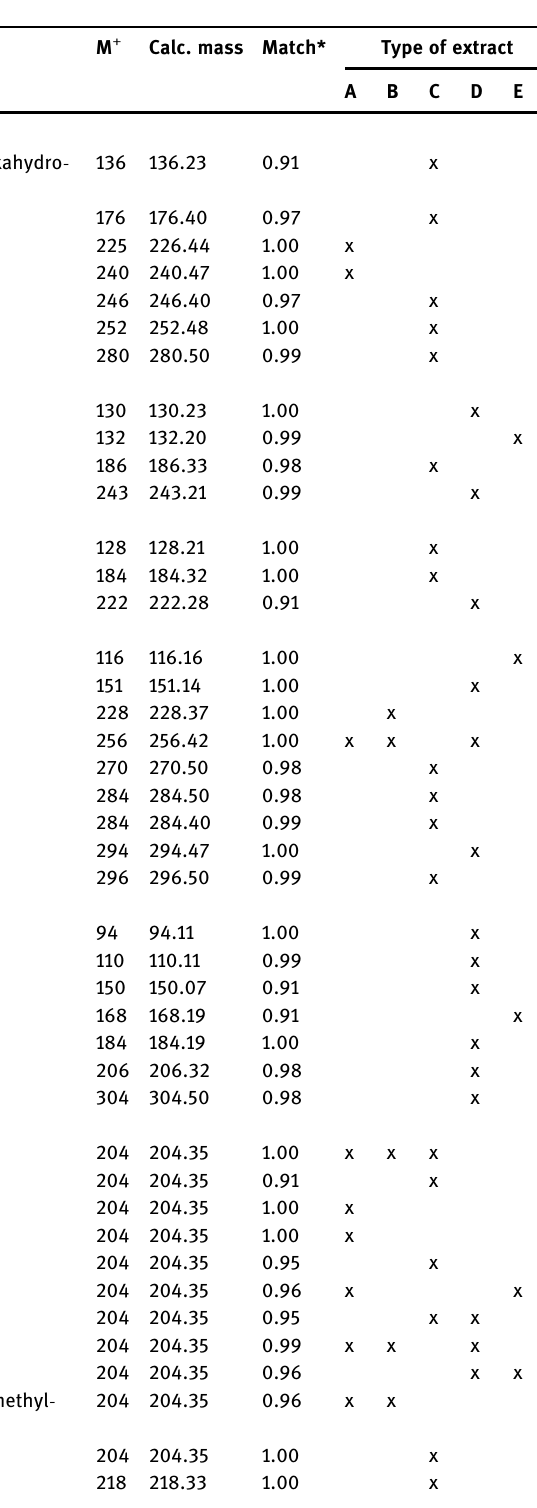
Table 1: Identi fi ed components in mango stem bark extracts, Haden variety. Extract A: Soxhlet extraction from dried stem bark; extract B: simultaneous steam distillation - solvent extraction of industrial spray - dried stem bark extract ( MSBE ) ; extract C: hexane eluate by pre - parative chromatography from extract A; extract D: hexane – ethyl acetate ( 1:1 ) eluate by preparative chromatography from extract A; extract E: ethyl acetate eluate by preparative chromatography from extract A ( Match = 1.00 means mass spectra comparison with authentic